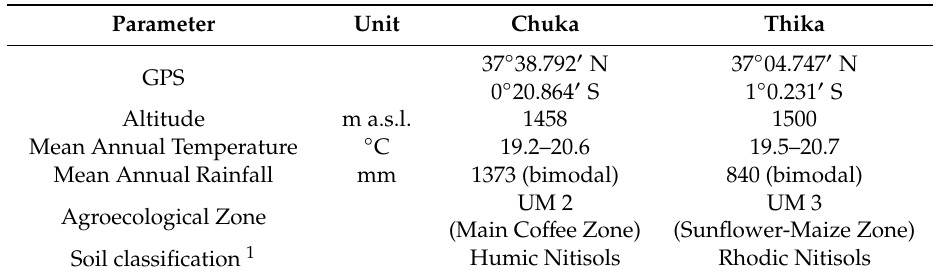
Table 1. The site characteristics of the farming systems comparison trial sites at Chuka and Thika, Central Highlands of